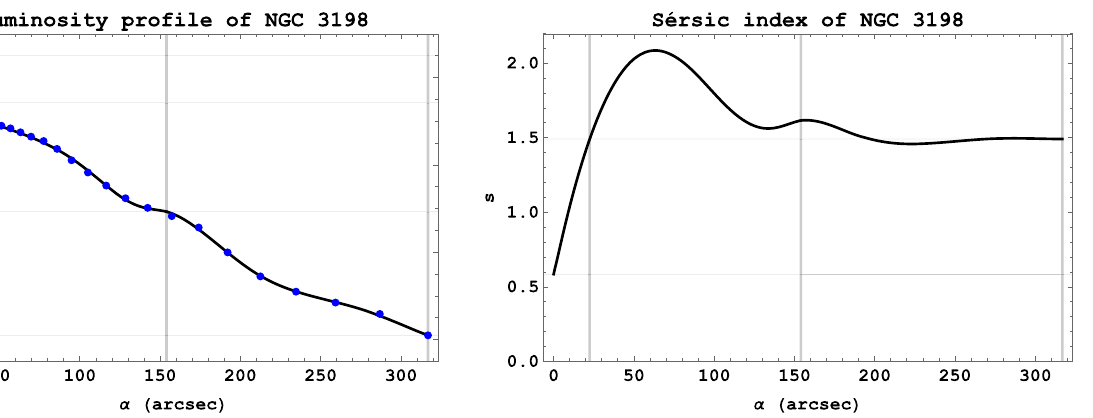
asdescribedinthetext. Theverticallinesinboth graphics correspond to the effective half-angle α eff = 22 . 4arcsec and to the transition position α = 154 . 0arcsec. The profiles extend to the last measurement taken 0 at l ρ = 14 . 1 kpc